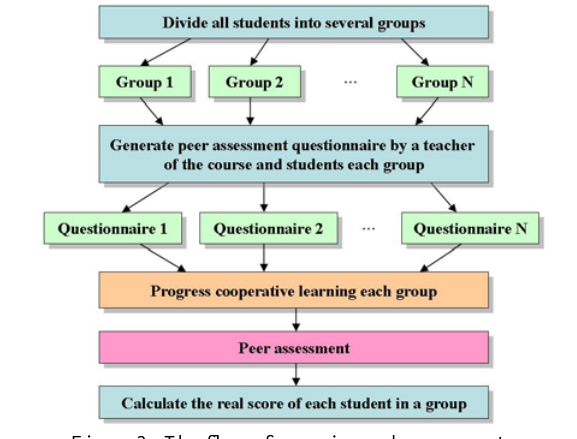
Figure 3. The flow of grouping and assessment